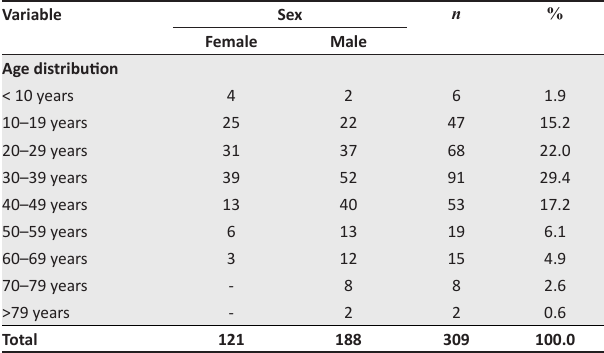
TABLE 1: Age and sex distribution of decedents.